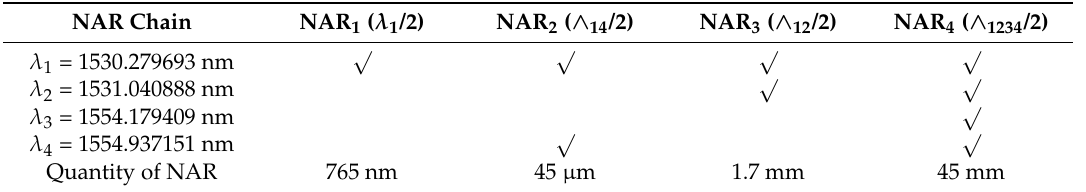
Table 1. NAR chain and wavelength selection of the constructed multi-wavelength interferometry (MWI). NAR Chain NAR 1 ( λ 1